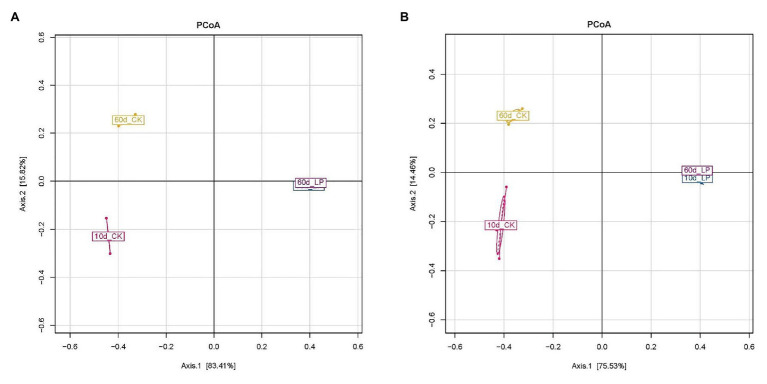
Principal Coordinate Analysis of bacterial communities in alfalfa silage based on the results illustrated by RQS (A) and AQS (B). CK, control; LP, inoculated with L. plantarum A345. The numbers ahead of CK and LP stand for ensiled days of silage.